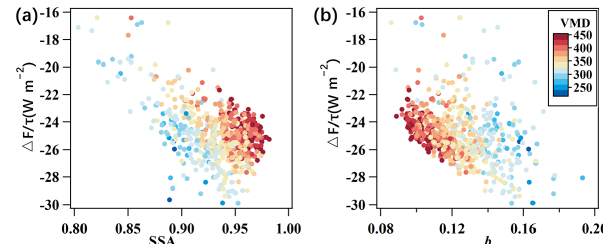
Figure 12. Radiative forcing efficiency ( (cid:49)F/τ) at λ = 525nm as a function of (a) SSA and (b) backscatter fraction, and volume mean diameter (VMD in nm) of the size distribution.